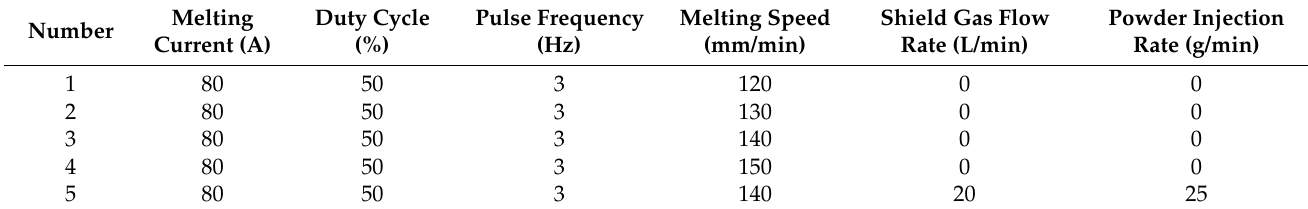
Table 2. Experiment parameters of DP-MIG wire welding additive manufacturing of 2319 alumi- num alloy.